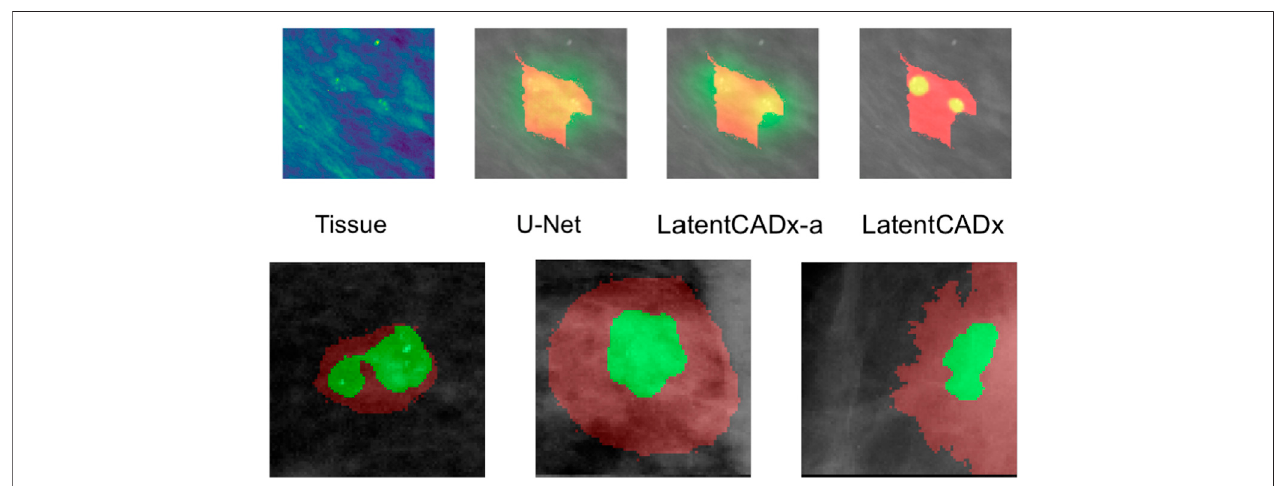
FIGURE 8 | Multi-Modal Detection Top, predictions across models on a sample with multi-modal spread of calci fi cations. Bottom, detailed view of multi-modal predictions (Mammograms obtained from (Lee et al., 2006); CC BY open access license).